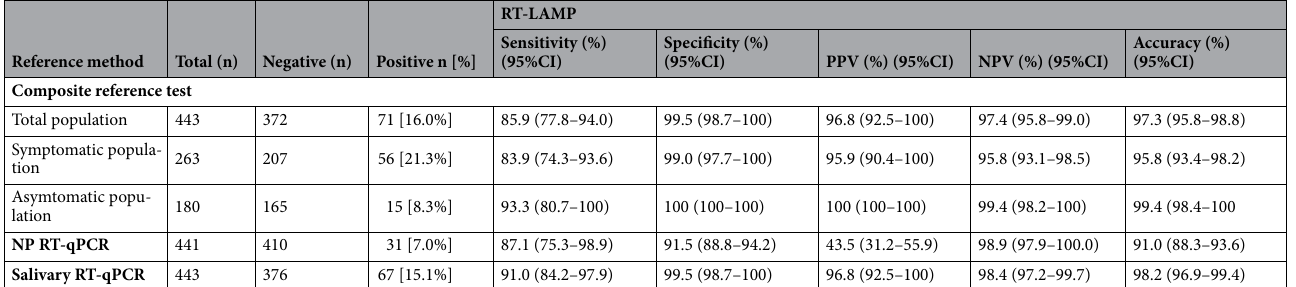
Table 3. Performances of RT-LAMP compared to different reference methods. Data are reported as number of individuals or percentage, in parentheses are 95% CI and in brackets are prevalence. RT-qPCR reverse Negative Predictive